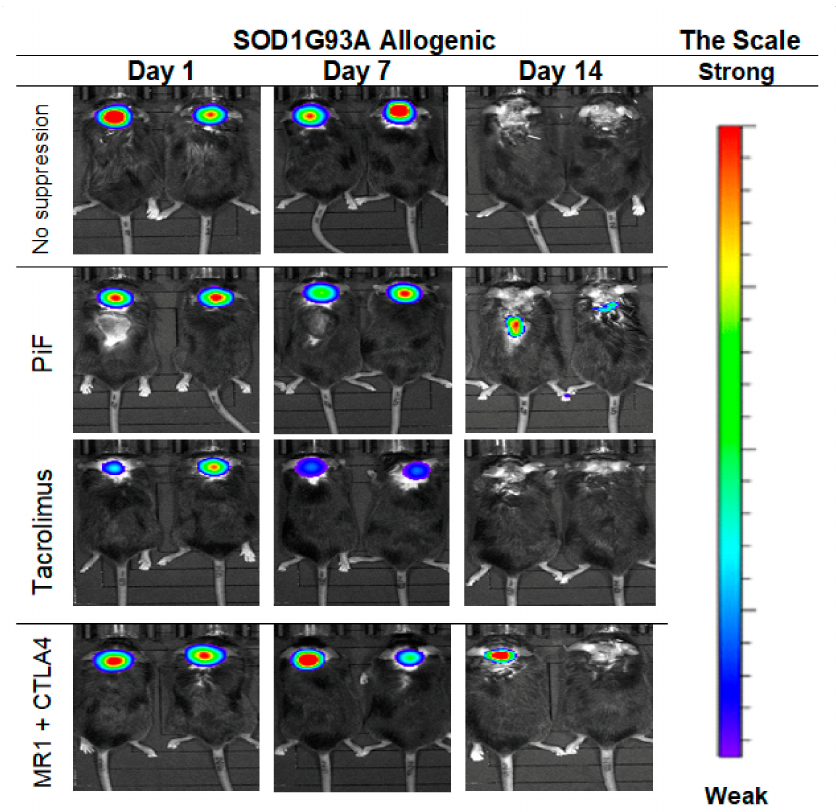
Figure 13. Murine GRP’s survival after cell transplantation in ALS- SOD1G93A allogenic model: The picture represents the observation performed on days 1, 7, and 14. The best visible signal on day 14 was detected in PiF and co-stimulatory blockade variants. Abbreviations: ALS-amyotrophic lateral sclerosis; GRP-glial-restricted progenitor cell; PiF-preimplantation